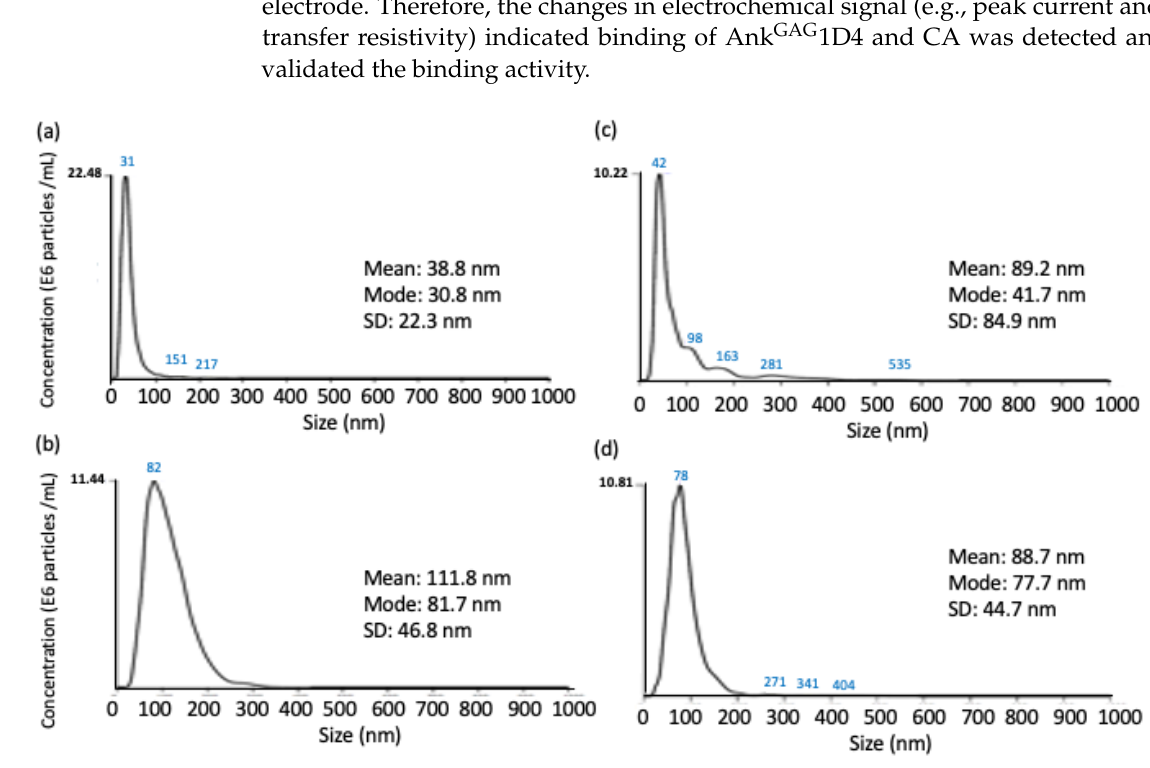
Figure 4. The average size of DARPin-conjugated colloidal gold before and after binding with HIV-1 CA. Size of ( a ) Ank GAG 1D4-conjugated colloidal gold, ( b ) Ank GAG 1D4-Y56A conjugated colloidal gold, ( c ) Ank GAG 1D4 conjugated colloidal gold upon binding with CA and ( d ) Ank GAG 1D4-Y56A conjugated colloidal gold upon binding with CA under measurement of nanoparticle tracking analysis.